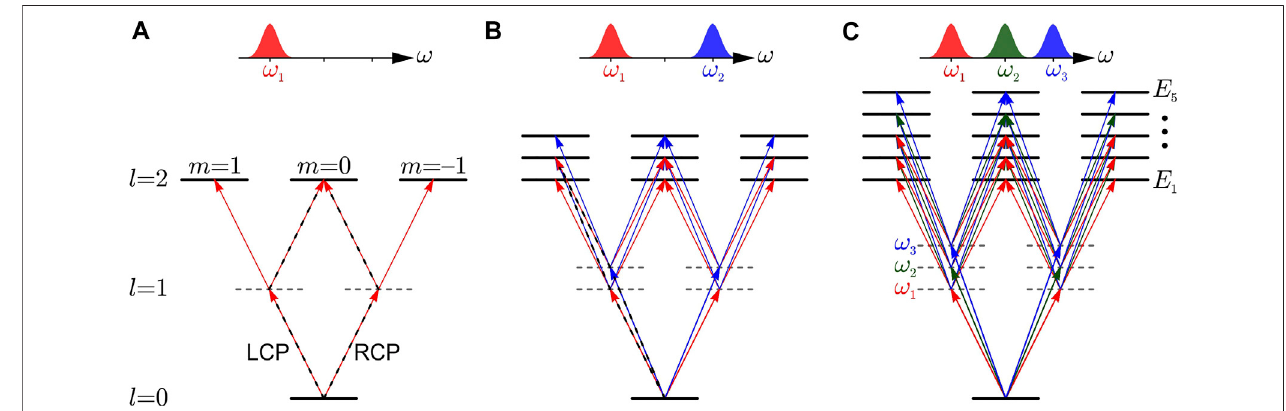
FIGURE 2 | Pathways for intraband MPI with N (cid:2) 2 photons using elliptically polarized multichromatic pulse sequences: (A) M (cid:2) 1 single-color, (B) M (cid:2) 2 bichromatic, (C) M (cid:2) 3 trichromatic pulses. The black dotted lines on top of the arrows indicate a pair of indistinguishable